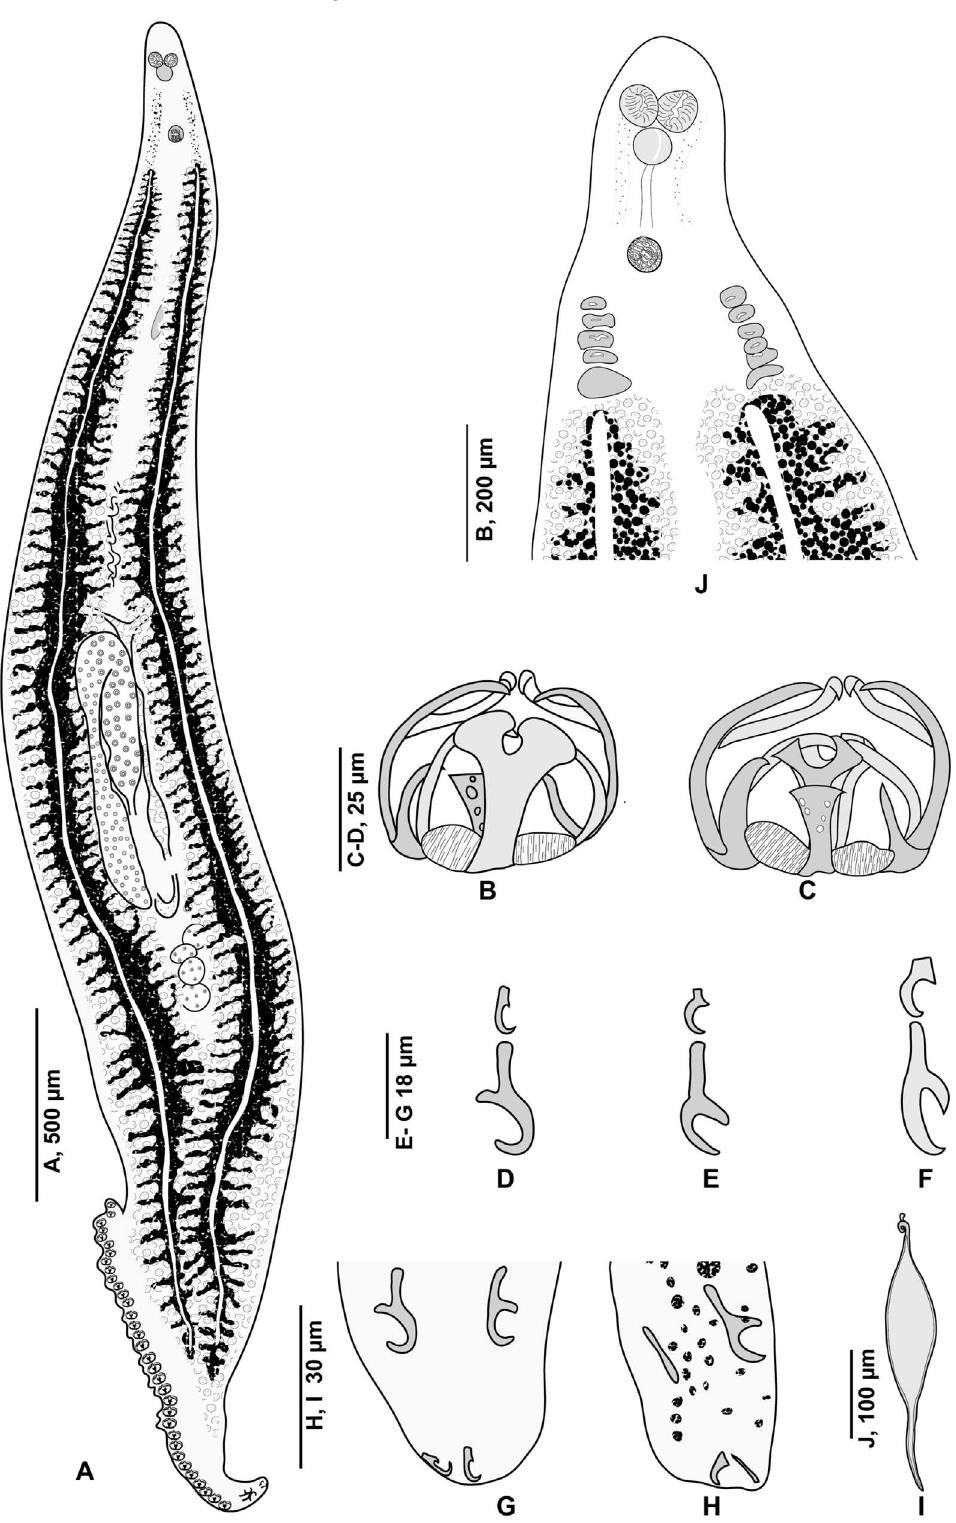
Figure 2. Pseudaxine trachuri Parona & Perugia, 1890. (A) Entire worm, typical specimen without a vagina, MNHN HEL1278; (B) clamp, ventral view; (C) clamp, dorsal view, MNHN HEL1278; (D – F) anchors from terminal lappet, MNHN HEL1279, HEL1280; (G and H), terminal lappet, MNHN HEL1280, HEL1281; (I) egg, MNHN HEL1282. (J) anterior extremity of a specimen from Boops boops , showing apparent “ multiple lateral vaginae ” (MNHN